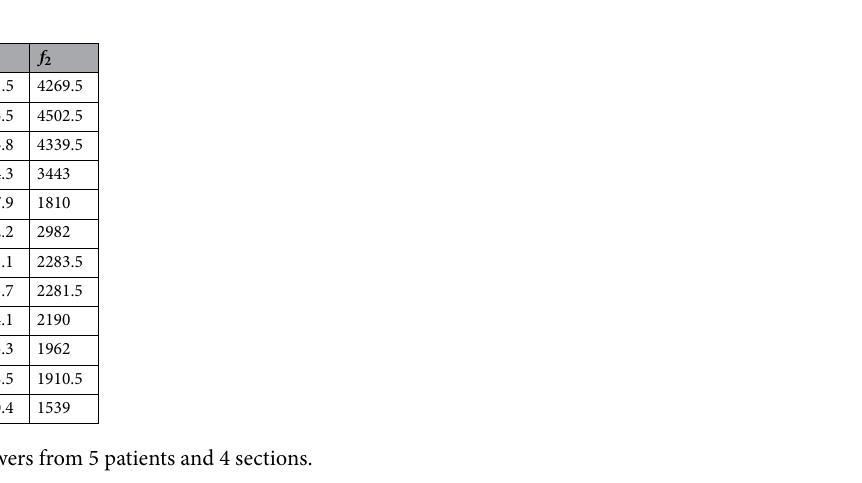
Table 7. Problem parameters 5 patients and 4 units. It is assumed that the time of the patient’s presence occurred at time 0, and that of the three patients, patient 3 entered the door of emergency patients. That is, patient 3 has a higher priority with fairness. It is also assumed that there is only one person in each department to serve and provide services. The rate of decrease in patient satisfaction due to increased hospital stay is set at 0.2.